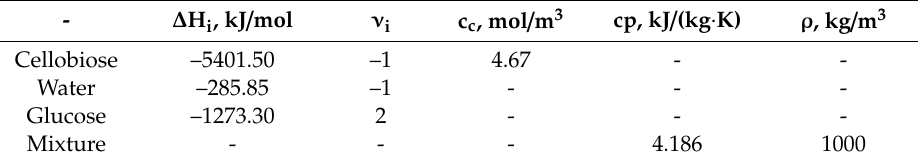
Table 2. Parameters used to calculate the adiabatic temperature